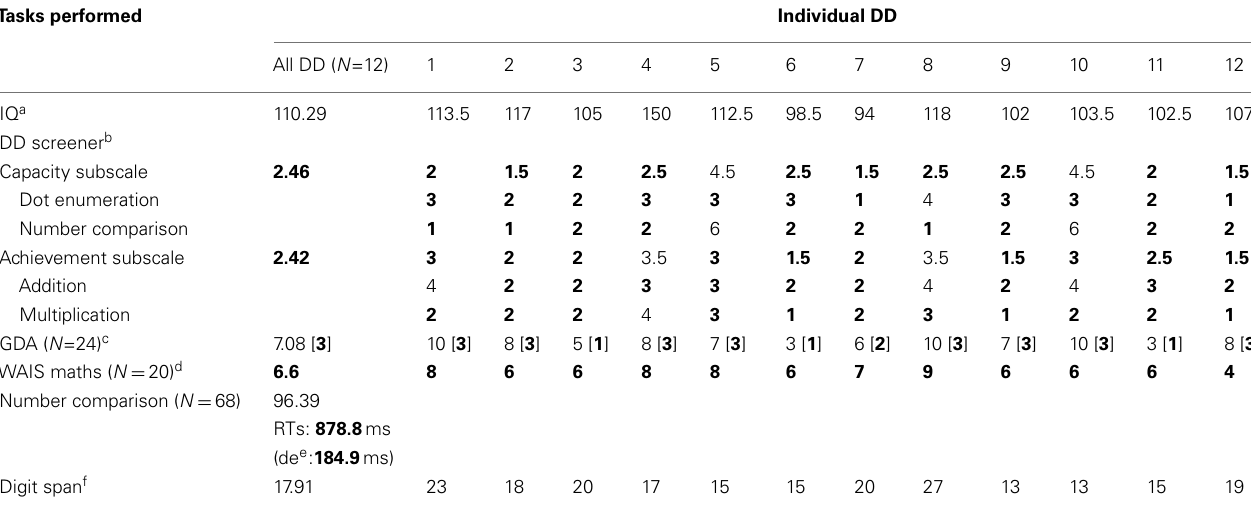
Table 1 | Dyscalculic participants’ performance in the Dyscalculia Screener and in other background tasks. Percent correct or scaled-scores. Tasks